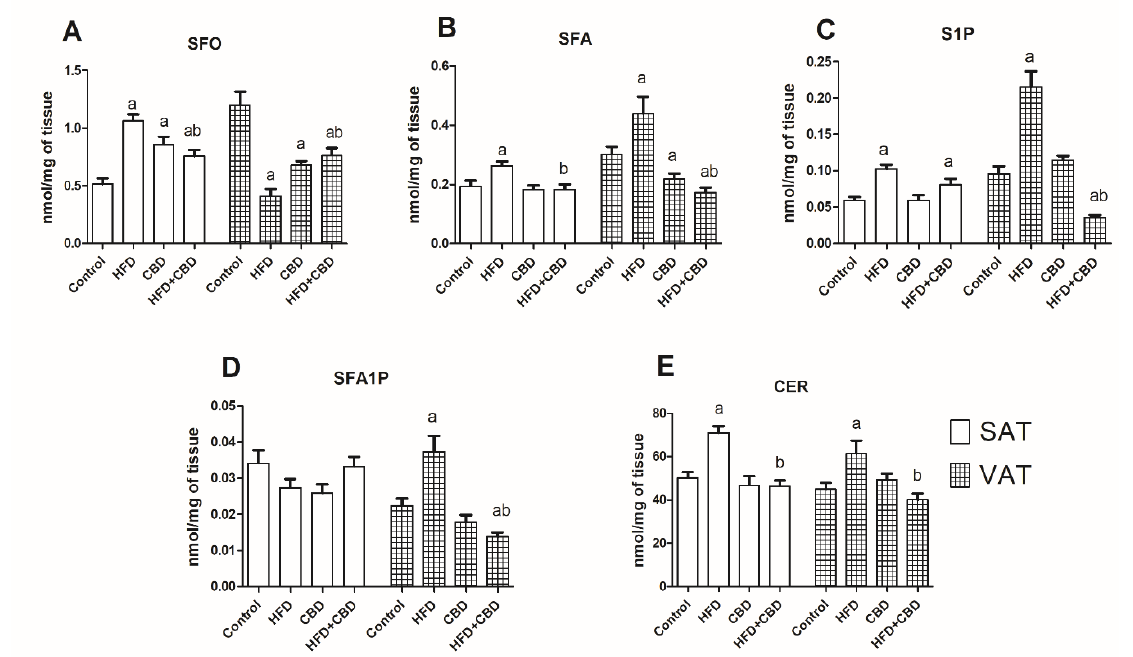
Figure 1. The concentrations of sphingolipids in the subcutaneous (SAT) and visceral (VAT) adipose tissues of rats fed a standard rat chow (control) or high-fat diet (HFD) after chronic cannabidiol (CBD) treatment: ( A ) sphingosine (SFO), ( B ) sphinganine (SFA), ( C ) sphingosine-1-phosphate (S1P), ( D ) sphinganine-1-phosphate (SFA1P), ( E ) ceramide (CER). The data are presented as mean values ± SD, n = 10 in each group. a p < 0.05: significant difference: control group vs. experimental group; b p < 0.05: significant difference: HFD vs. HFD+CBD.